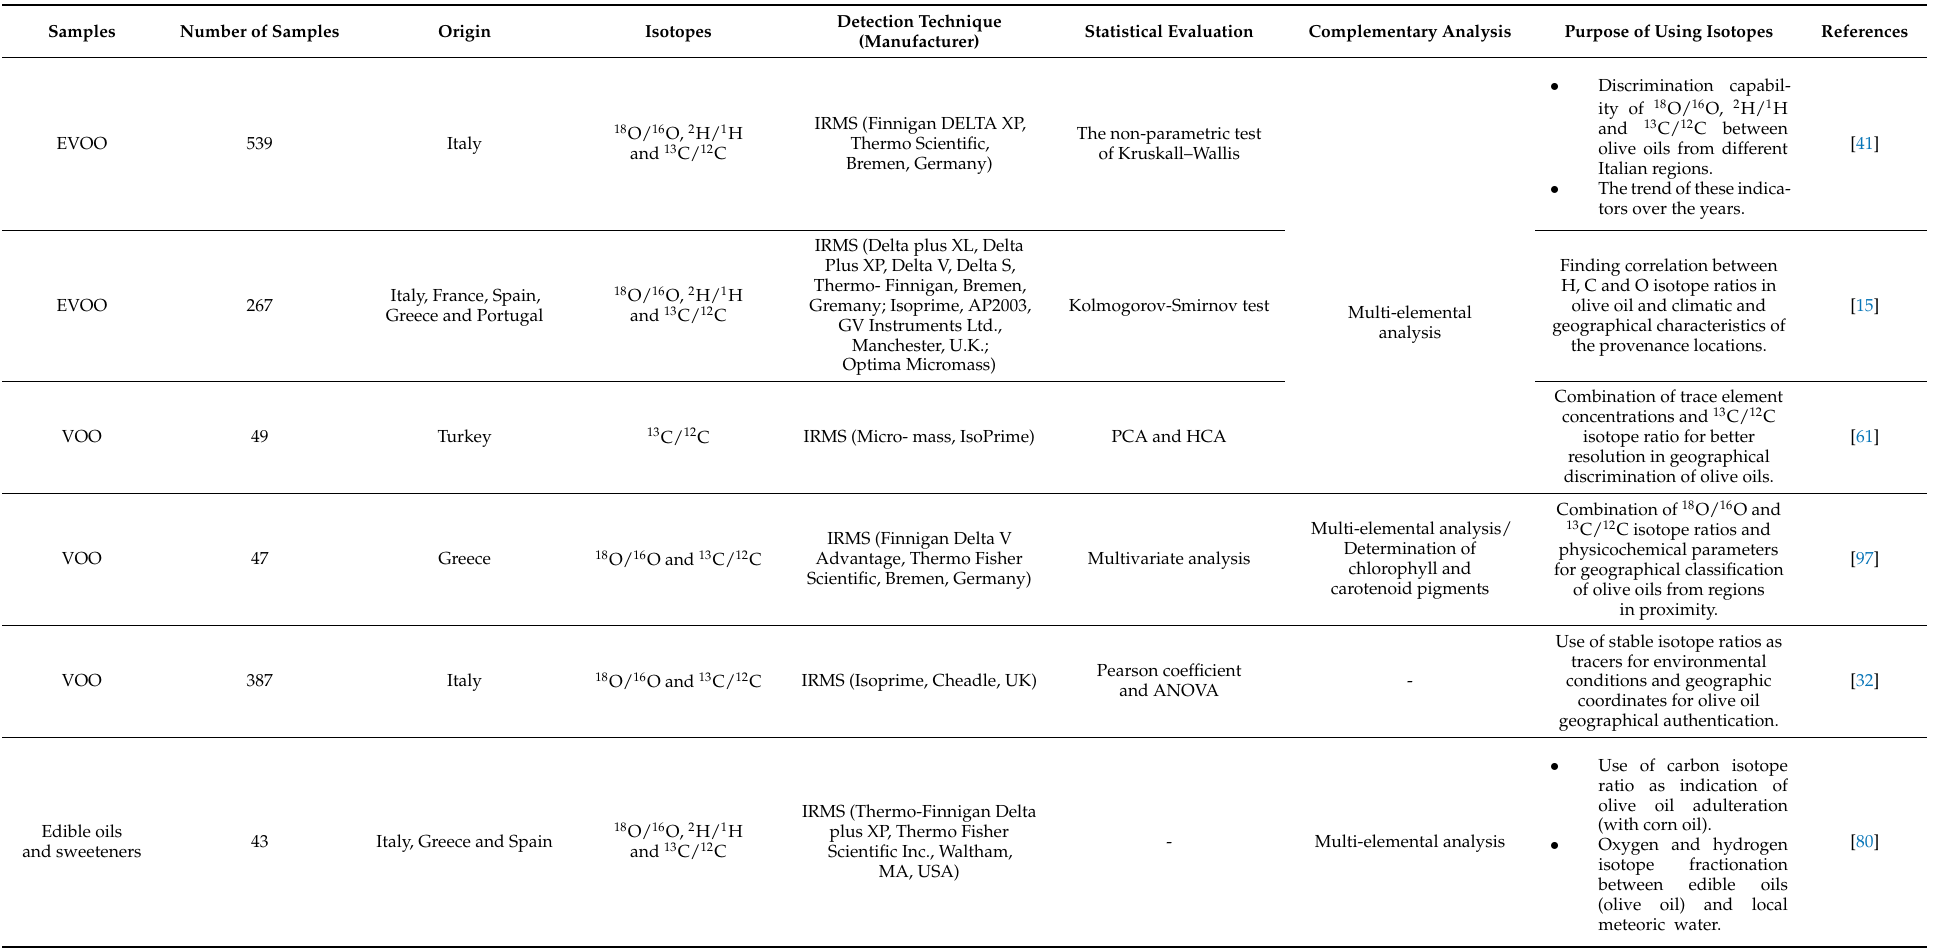
Table 2. Determination of isotopic ratios of light elements in olive oil and other edible